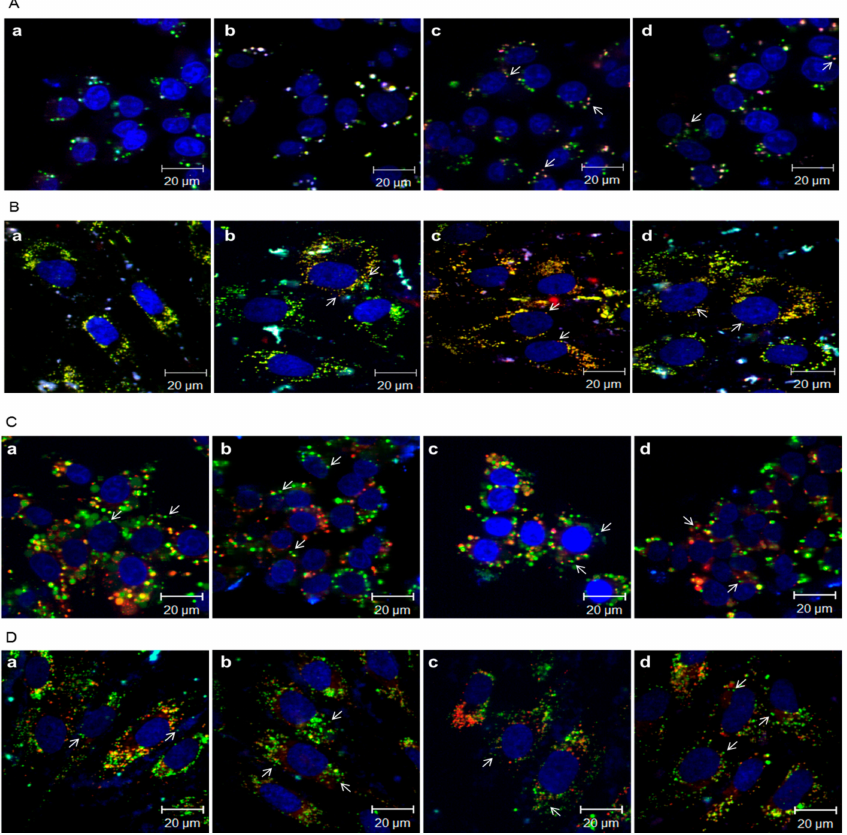
Figure 6. Cellular localization of the PAMAM-O dendrimer. HepG2 cells ( A ) and dermal fibroblasts ( B ) were transfected with Alexa Fluor 532-labeled 1 µ g of Flag or Flag-apoptin and Alexa Fluor 488-labeled PAMAM and PAMAM-O dendrimers at a weight ratio of 8. The micrographs indicate ( a ) PAMAM/Flag; ( b ) PAMAM/Flag-apoptin; ( c ) PAMAM-O/Flag; and ( d ) PAMAM-O/Flag-apoptin, 24 h after transfection. Flag or Flag-apoptin was stained by Alexa Fluor 532 and then visualized by confocal microscopy. The nuclei and polymers were stained with NucBlue Live Ready Probes and Alexa 488 (green). Arrows indicate Flag or Flag-apoptin labeled with Alexa Fluor 532 dye. Scale bar: 20 µ m. HepG2 cells ( C ) and dermal fibroblasts ( D ) were treated at the same conditions as in panels A and B. The micrographs indicate ( a ) PAMAM/Flag; ( b ) PAMAM/Flag-apoptin; ( c ) PAMAM-O/Flag; and ( d ) PAMAM-O/Flag-apoptin. Lysosomes were stained with LysoTracker Deep Red (red). The nuclei and polymers were stained with NucBlue Live Ready Probes and Alexa 488 (green). Arrows indicate PAMAM and PAMAM-O labeled with Alexa Fluor 488 dye. Scale bar: 20 µ